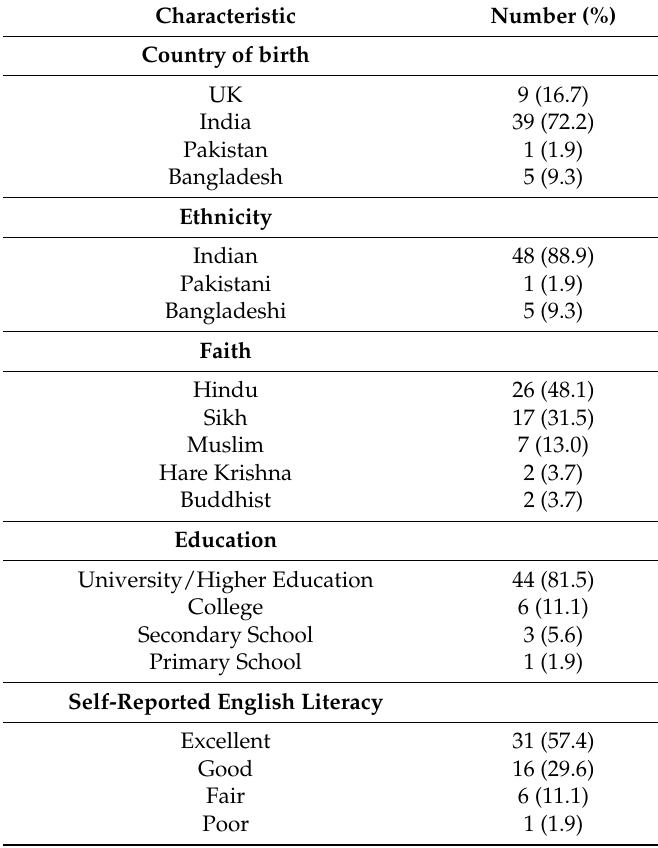
Table 2. Demographic characteristics of the 54 South Asian men with valid accelerometry